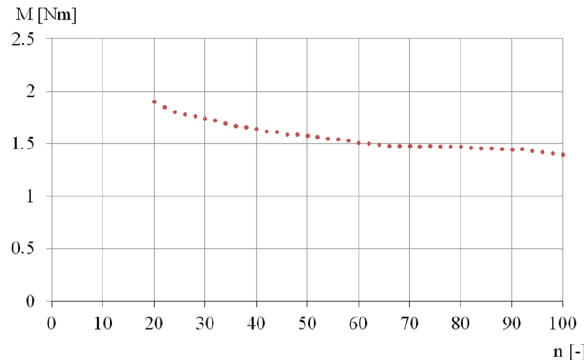
Figure 7. Dependence of the torque on the radius r w and on the radius R.